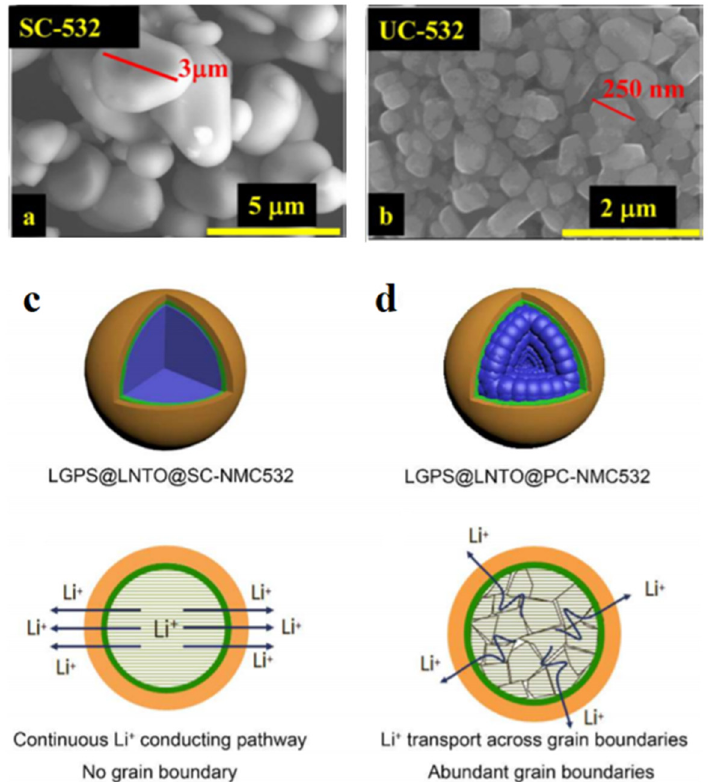
Figure 6. SEM images of single-crystalline and polycrystalline structure of NMC ( a , b ) [67], and illustration of the Li + transport in single and polycrystalline ( c , d ) [68].